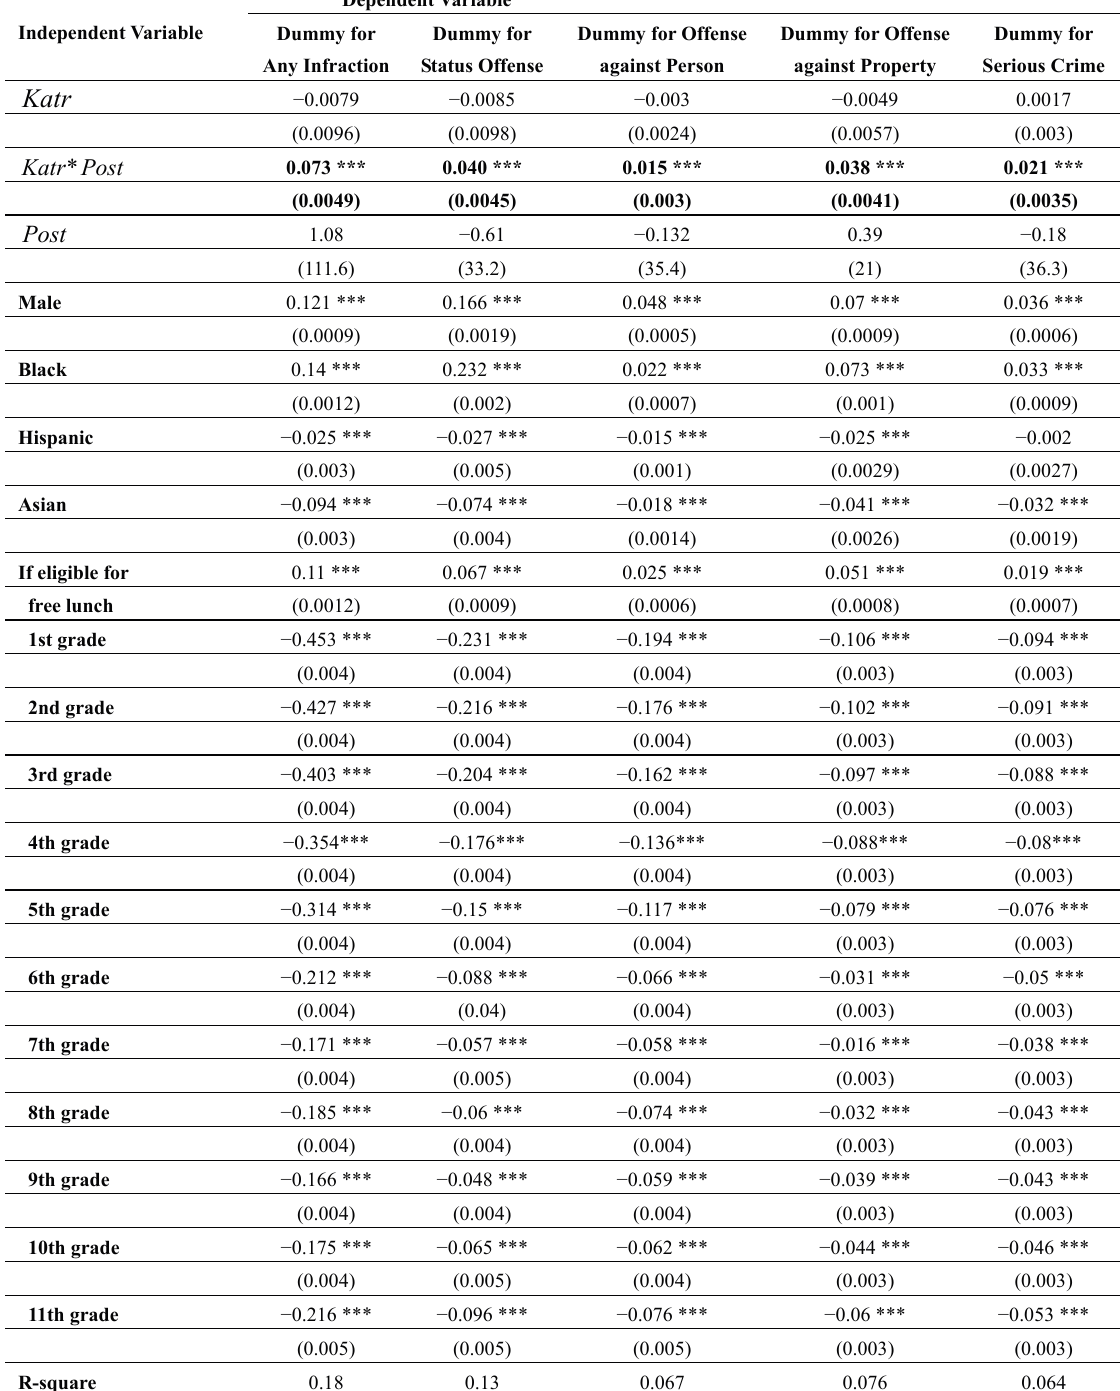
Table 5. Effect of Hurricane Katrina on displaced students’ likelihood of discipline infraction (N =